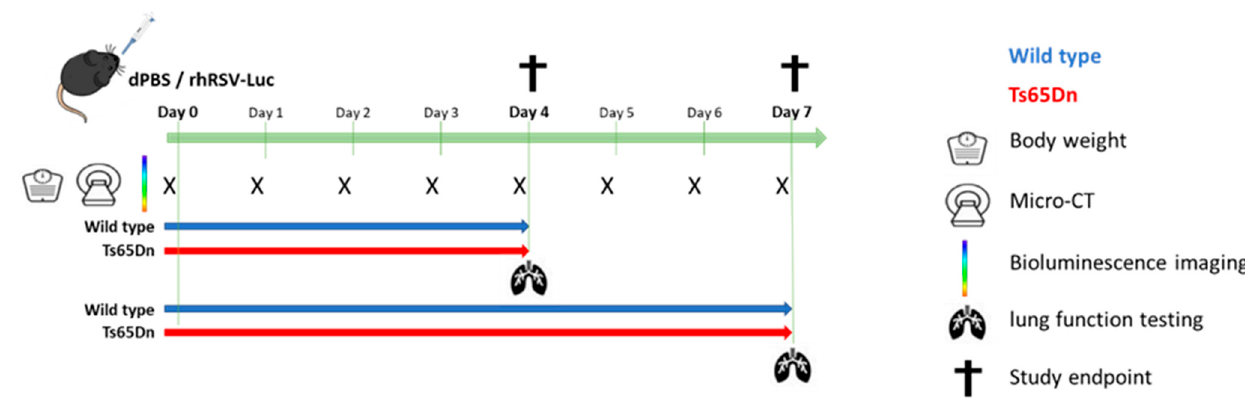
Figure 1. Schematic overview of the experimental setup. Six- to seven-week old wild type (blue) and Ts65Dn (red) mice received intranasal instillation with dPBS or rhRSV-Luc at d0. Mice were longitudinally monitored daily for body weight, with micro-computed tomography (micro-CT) and bioluminescence imaging (BLI). At study endpoint at four and seven days after infection, invasive lung function measures were performed, and tissue samples collected for immunological analyses. The number of animals ranged between four and six between the different groups (wild type vs Ts65Dn, sham infected vs rhRSV-Luc infected, 4 days p.i. vs 7 days p.i.).